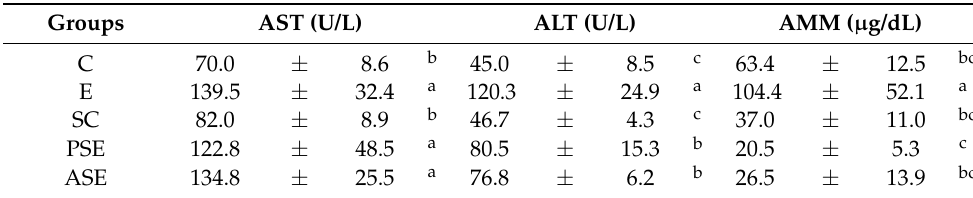
Table 3. Effects of synbiotics supplementation on plasma aspartate aminotransferase (AST) and alanine aminotransferase (ALT) activities and ammonia (AMM) levels in rats with chronic ethanol